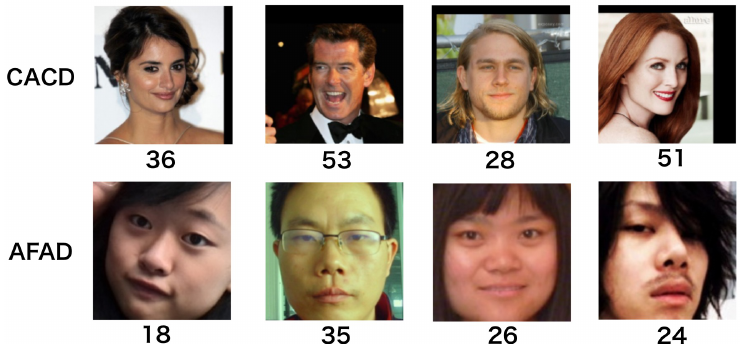
Figure 3. Examples from Cross-Age Celebrity Dataset [15] and Asian Face Age Dataset [12]. The number below each image is the ground truth age of the